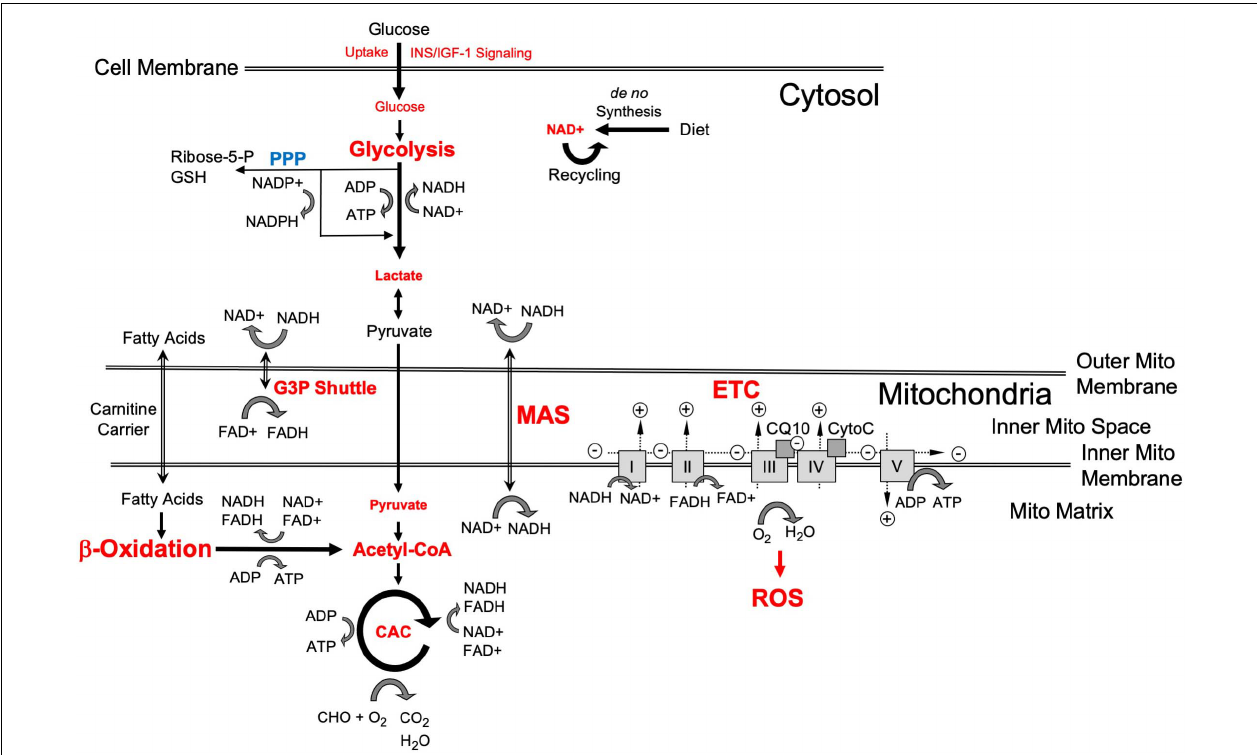
FIGURE 1 | Schematic representation of cellular energy flow and substrate metabolism [adapted from Ryu et al. (2021)]. Red indicates bioenergetic processes and “branch points” where changes in late-onset Alzheimer’s disease (LOAD) cells occur as described in the text. Small script indicates LOAD-associated reductions and large script indicates increases in bioenergetic cell functions. A key metabolite is glucose whose uptake is controlled by INS/IGF-1 signaling and which is processed through glycolysis to pyruvate and may be converted to lactate. Lactate can be converted back to pyruvate, which is used in the mitochondria to produce Acetyl-CoA and oxaloacetate to fuel the citric acid cycle (CAC) that generates the reducing agents FADH 2 and NADH. NADH is the reduced form of NAD + that is newly synthesized or recycled and serves as a proton and electron transfer molecule. The protons and electrons carried by NADH and FADH 2 are used to generate a proton gradient in the electron transfer chain (ETC), which includes complexes I–V, coenzyme Q, and cytochrome C, and leads to the production of ATP by OxPhos that produces H 2 O and reactive oxygen species (ROS). Because glycolytically produced cytosolic NADH cannot pass the outer mitochondrial membrane, protons and electrons are transported through the glycerol-3-phosphate (G3P) shuttle and malate aspartate shuttle (MAS) which generate FADH 2 in the intermembrane space and NADH in the mitochondrial matrix, respectively. Fatty acids are transported to the mitochondria through carnitine carriers and their metabolism in β -oxidation is an alternative pathway to produce FADH 2 , NADH, ATP, and Acetyl-CoA. The pentose phosphate pathway (PPP) produces ribose-5- and xylulose-5-phosphate leading to the reduction of NAPD + to NAPDH that is used for fatty acid biosynthesis and regeneration of reduced glutathione (GSH) to neutralize